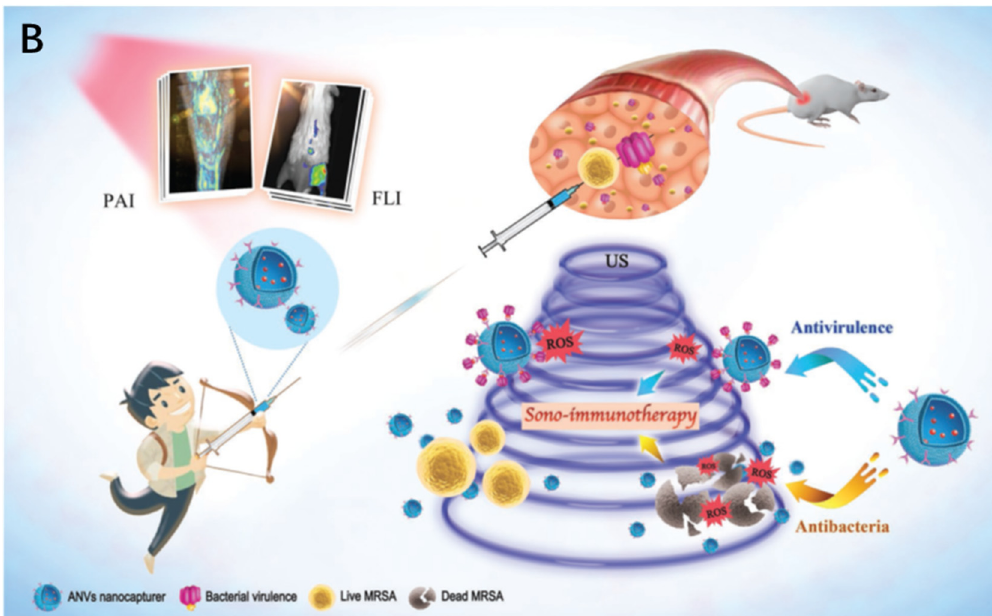
Figure 5. Schematic illustration of experimental procedures: ( A ) precise magnetic resonance imaging-guided sonodynamic therapy for drug-resistant bacterial deep infection (reproduced with permission from [73]; published by Elsevier, 2021); ( B ) sono-immunotherapeutic nanocapture to combat multidrug-resistant bacterial infections (reproduced with permission from [74]; published by John Wiley and Sons, 2021).